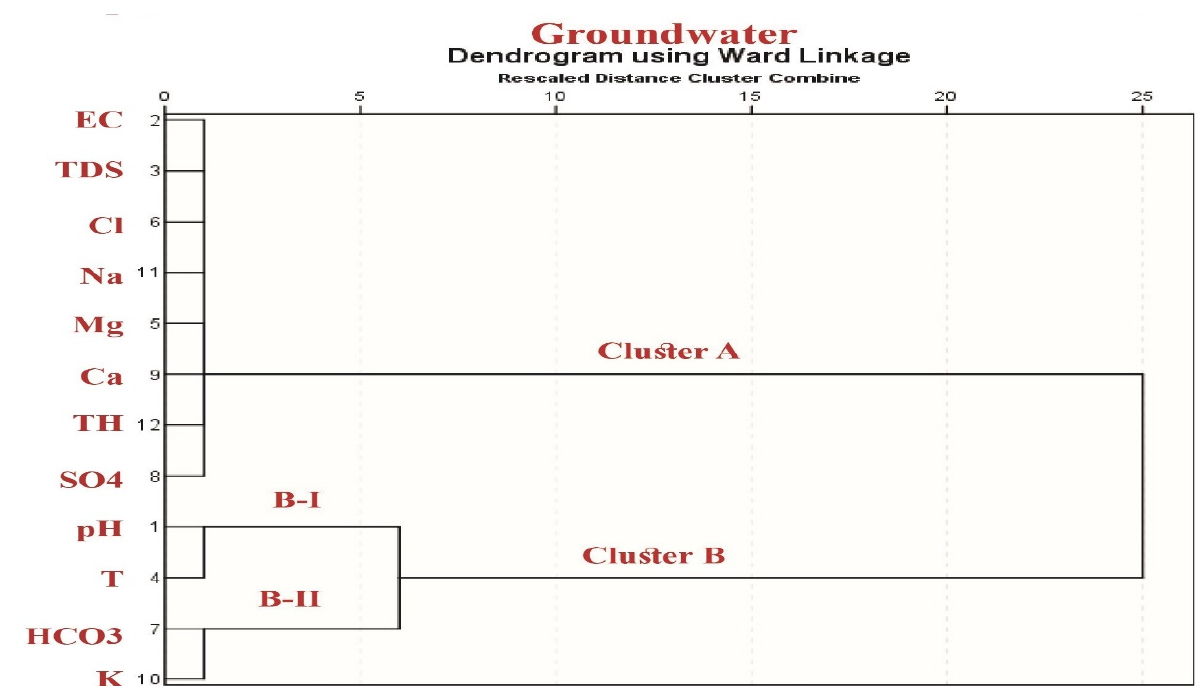
Figure 9. HCA showing the main clusters in the studied groundwater. Table 3. Variables of the principal component analysis for the studied groundwater.